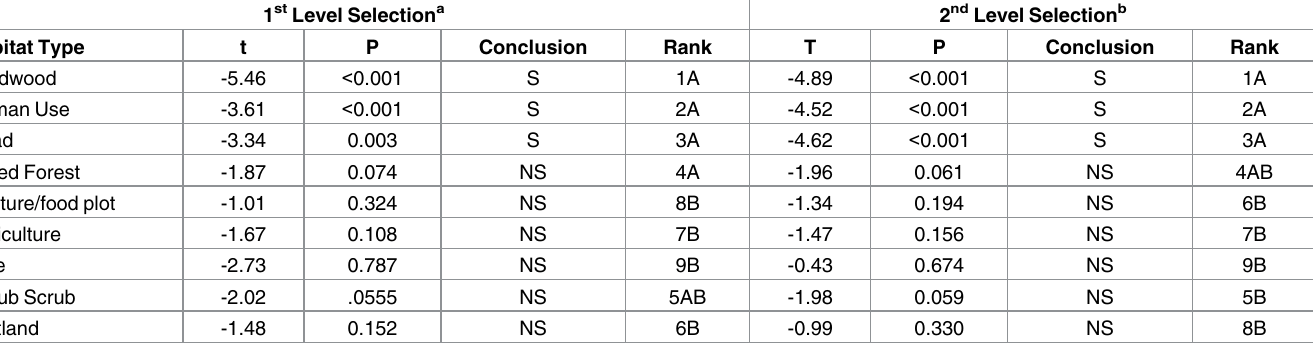
Table 1. Habitat types ranked in order of preference(1 most preferred-9 least preferred) at 2 spatial scales by gray foxes from 2014–2015 on the Joseph W. Jones Ecological ResearchCenter at Ichauway, and surrounding lands in Baker County, Georgia, USA. Significantdifferences ( P < 0.05) amongranks are indicatedby different letters. S = Selected, NS = Not Selected(used as expected).